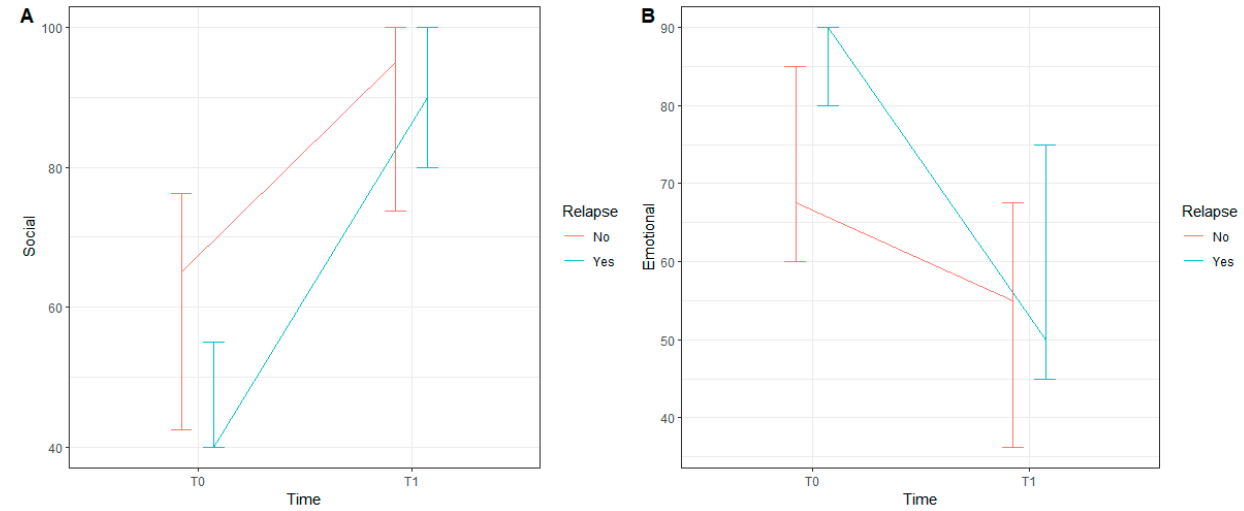
Figure 1 . Median, first and third quartiles of each condition for Social Functioning ( A ) and Emotional Functioning ( B ).